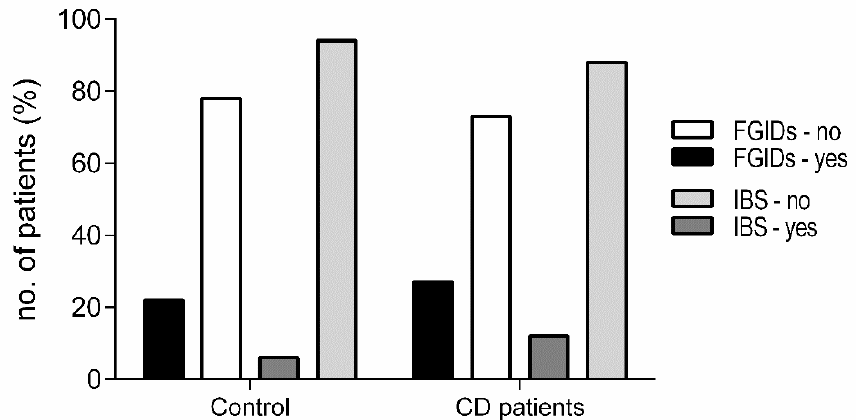
Figure 1. Presence of gastrointestinal symptoms. Data are shown as a percentage of individuals reporting IBS and FGIDs symptoms between both studied groups. IBS: Irritable bowel syndrome, FGIDs: Functional gastrointestinal disorders, CD: Celiac disease.